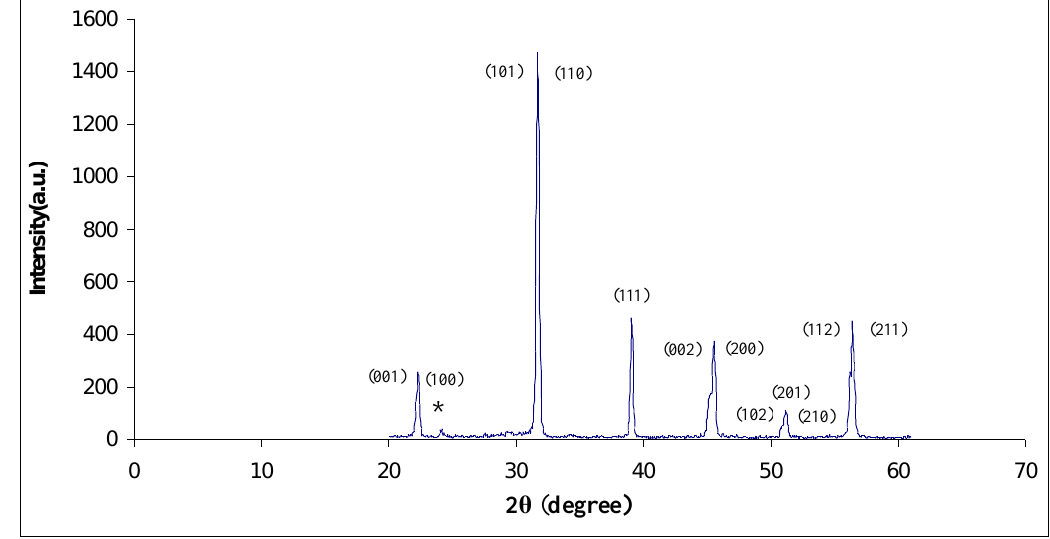
Fig. 5: XRD patterns for barium titanate at 1000 ° C.